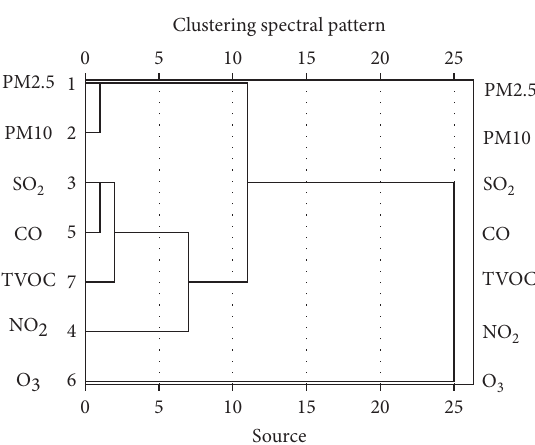
Figure 6: Cluster results of